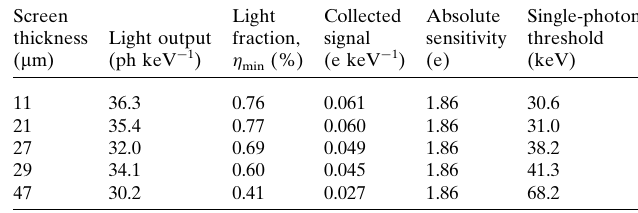
Table 5 Single X-ray photon sensitivity thresholds (with four pixels above the noise) with GOS:Tb scintillating screens and a camera pixel size of 6.5 m m.